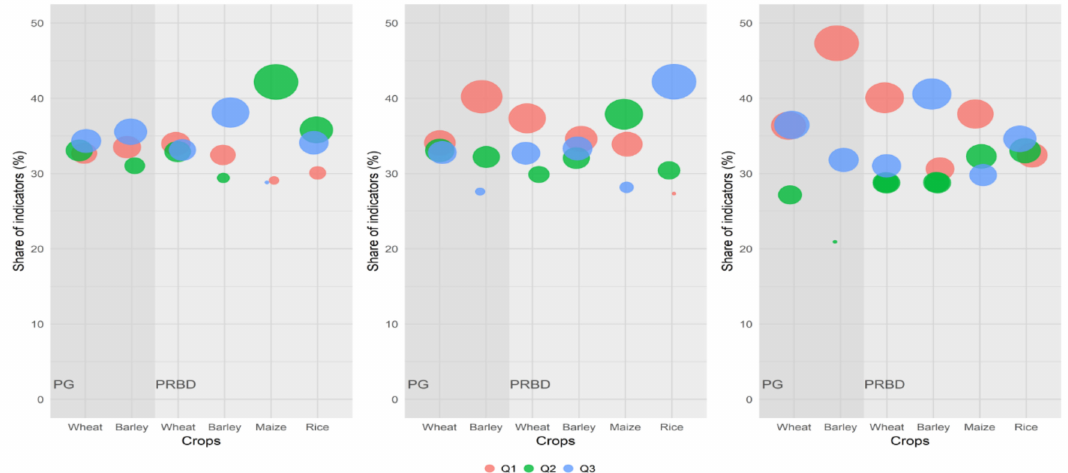
Figure 6. Percentage of indicators belonging to each of the three growing stages (Q1, Q2 and Q3) of the plant, as derived from the selected features by lasso models under the three spatial aggregation scales considered: municipality ( left ), agricultural district ( center ) and province ( right ).